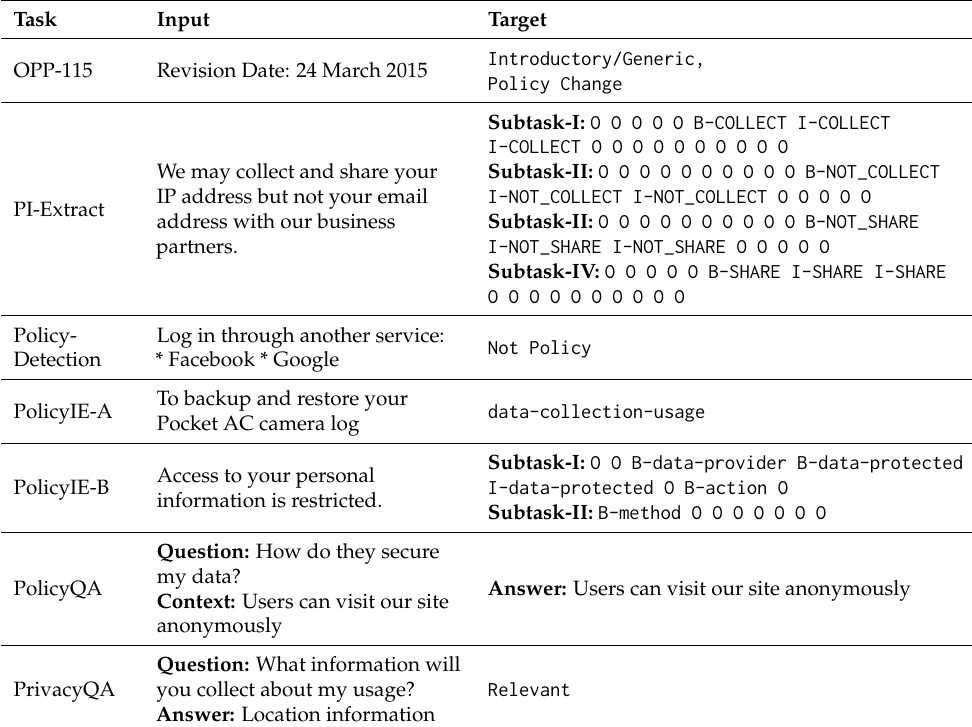
Table A2. Representative examples of each PrivacyGLUE benchmark task.